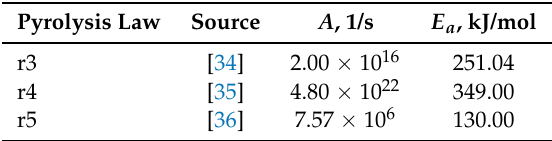
Table 6. Activation energies and pre-exponential factors for different HDPE pyrolysis laws (Equation (14)).